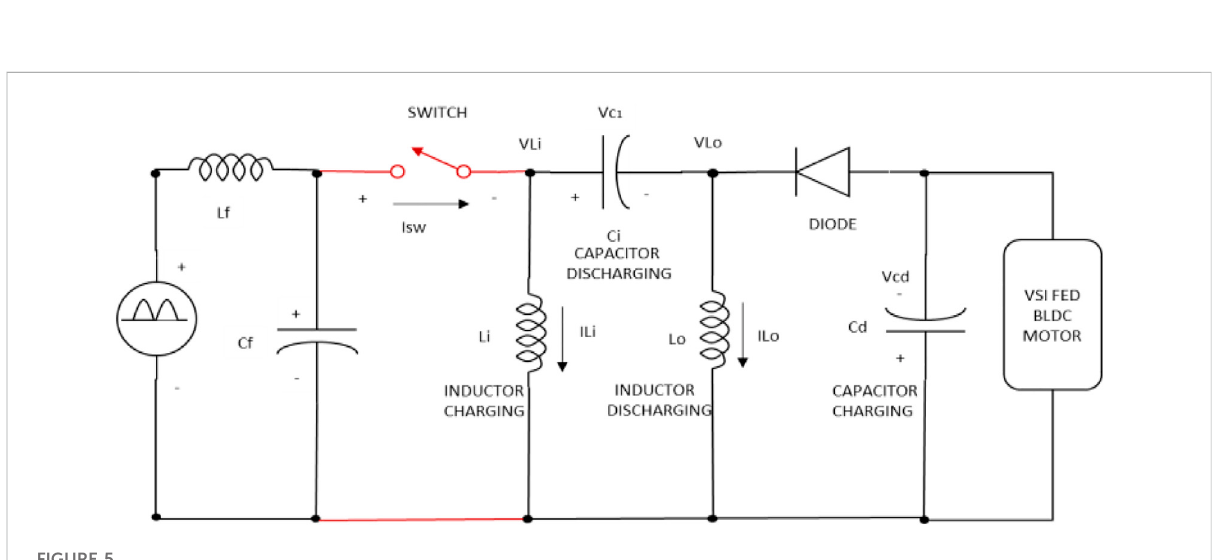
FIGURE 4 Mode 1 of modi fi ed Zeta converter.